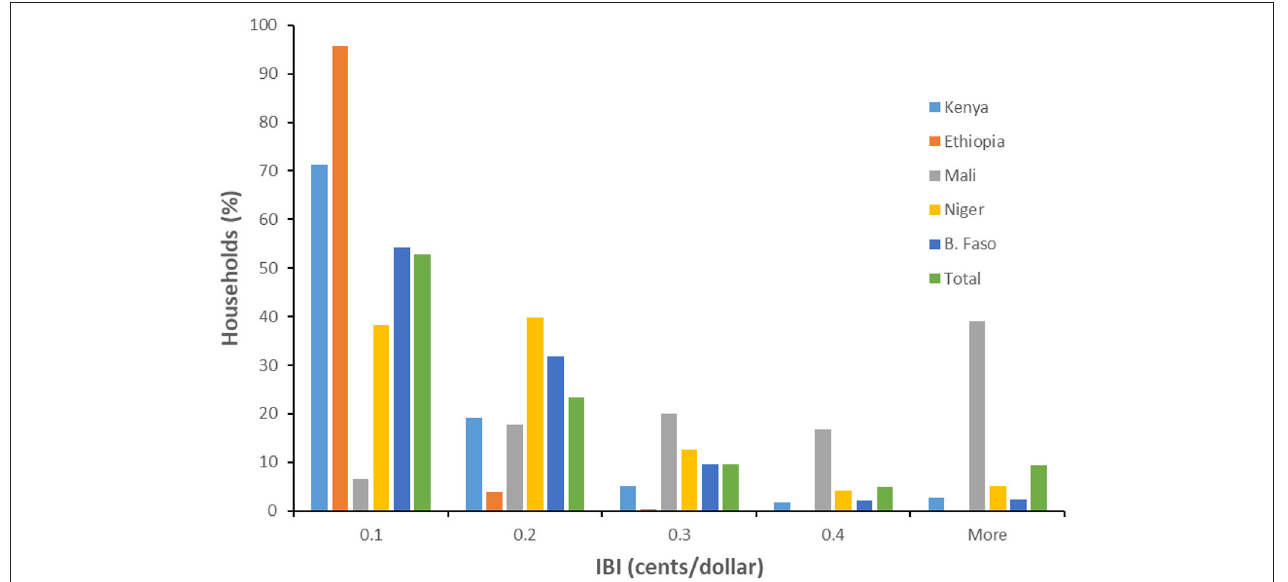
FIGURE 3 | The proportion of households with a given Intensification Benefit Index (cents/dollar).